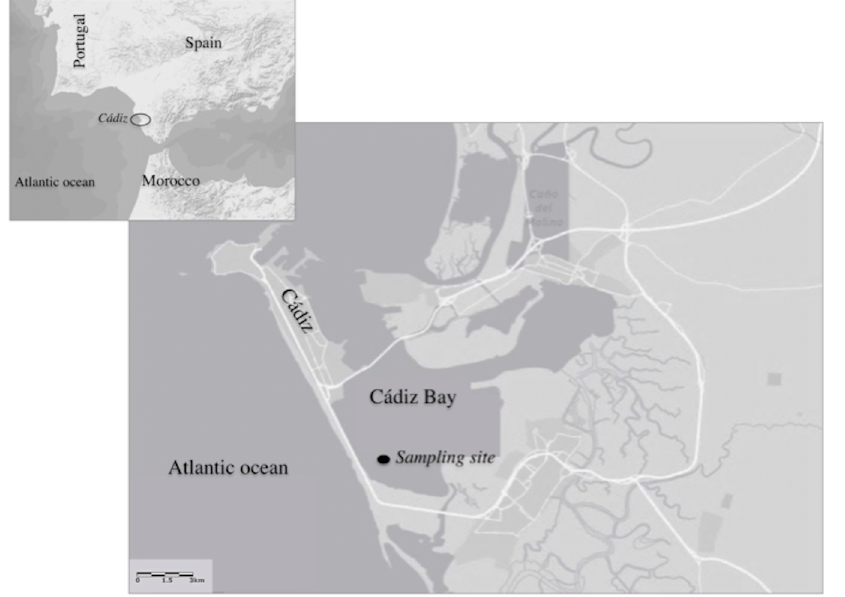
Fig 1. Study site at Ca´diz bay (36˚ 28’ 12.79” N, 6˚ 15’ 7.07” W),